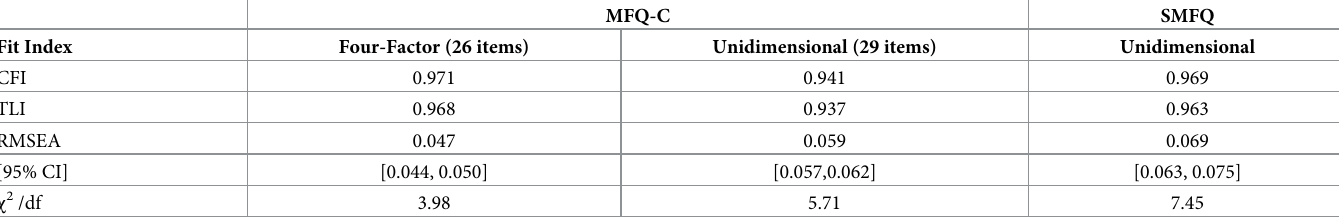
Table 2. Fit indices for confirmatory factor analyses models of the Mood and Feelings Questionnaire (MFQ-C) and Short Mood and Feelings Questionnaire (SMFQ-C).